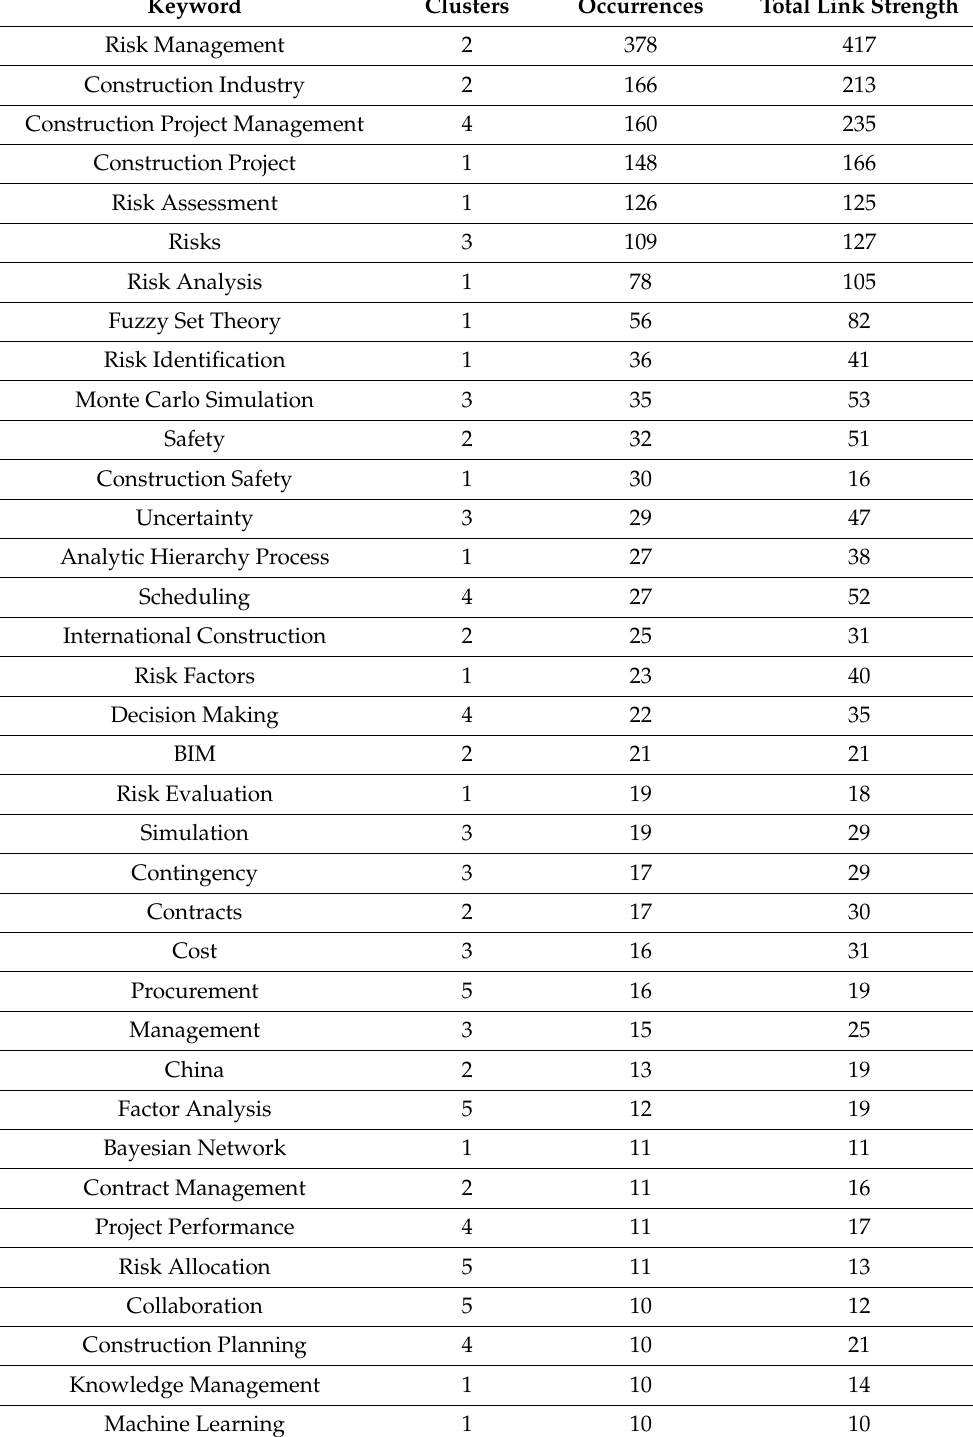
Table 4. Numerical analysis of author keywords of risk management in